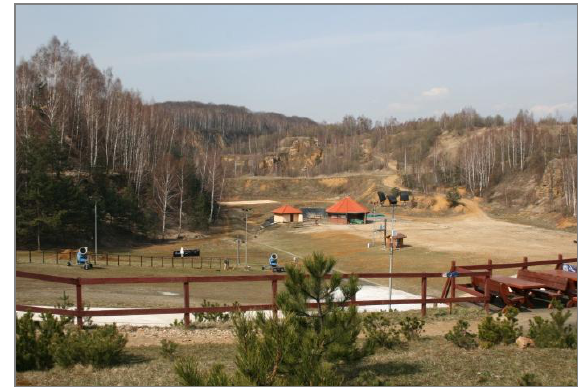
Fig. 2. “Dolomity – Sportowa Dolina” in Bytom. Dolomite quarry – an example of adopting land for recreation purposes ( U. Myga-Piątek